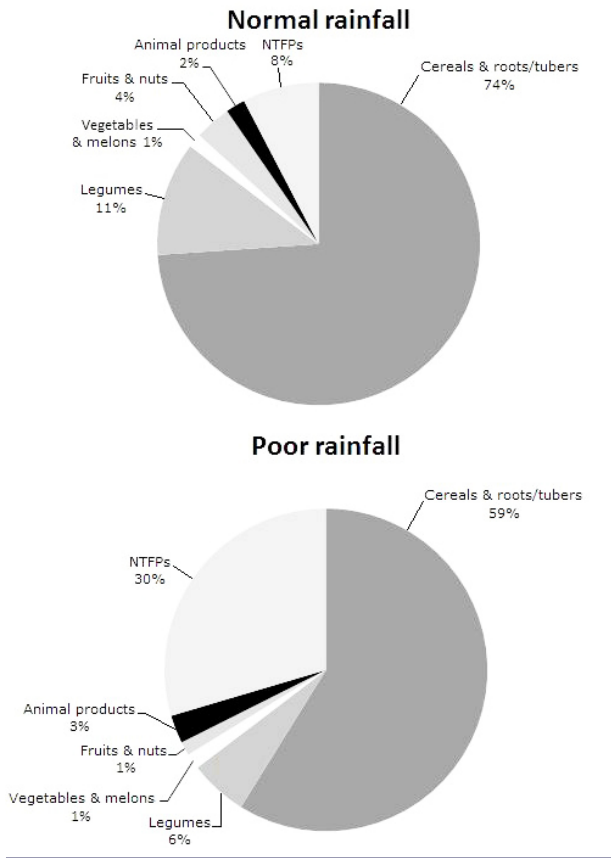
Fig. 7 . Contribution of nontimber forest products to energy consumption in times of normal and poor rainfall, shown in percentage of the total intake per person per year